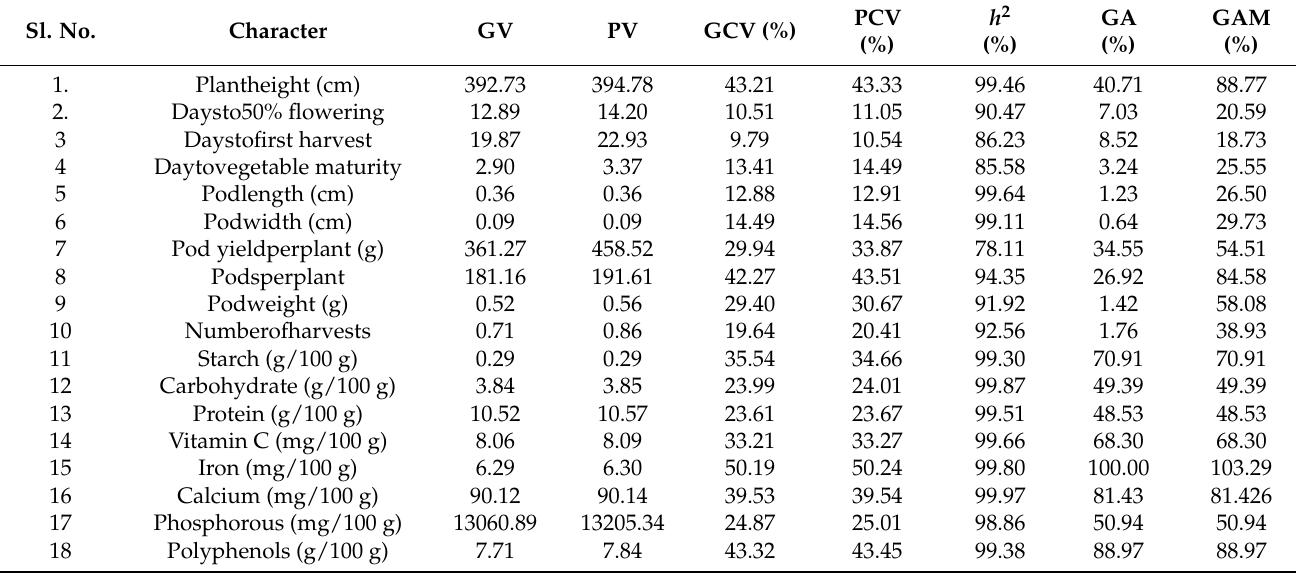
Table 2. Estimates of components of genetic advance, heritability, variance and genetic advance over percentage of mean for morphological and quality parameters in vegetable soybean. Sl. No.